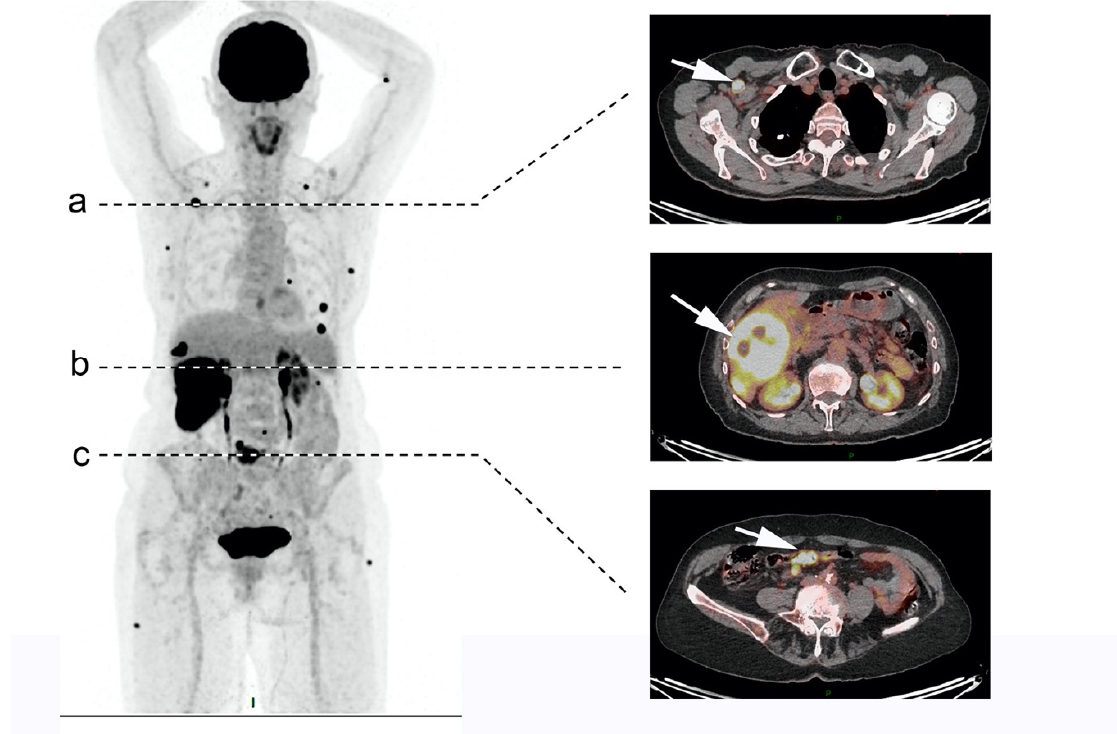
Figure 1. 18F-Fluorodesoxyglucose (18F-FDG) positron emission tomography (PET)-CT results for a 79-year-old patient with metastatic neuroendocrine carcinoma (NEC) of the ileum (Ki-67 100%). Pre-therapeutic 18F-FDG PET/CT revealed disseminated metastatic disease with intense FDG uptake: multiple cutaneous lesions, ( a ) right infra clavicular node (SUVmax = 12), ( b ) large hepatic lesion (SUVmax = 21.6), and ( c ) focal primitive ileum lesion (SUVmax = 13.3).